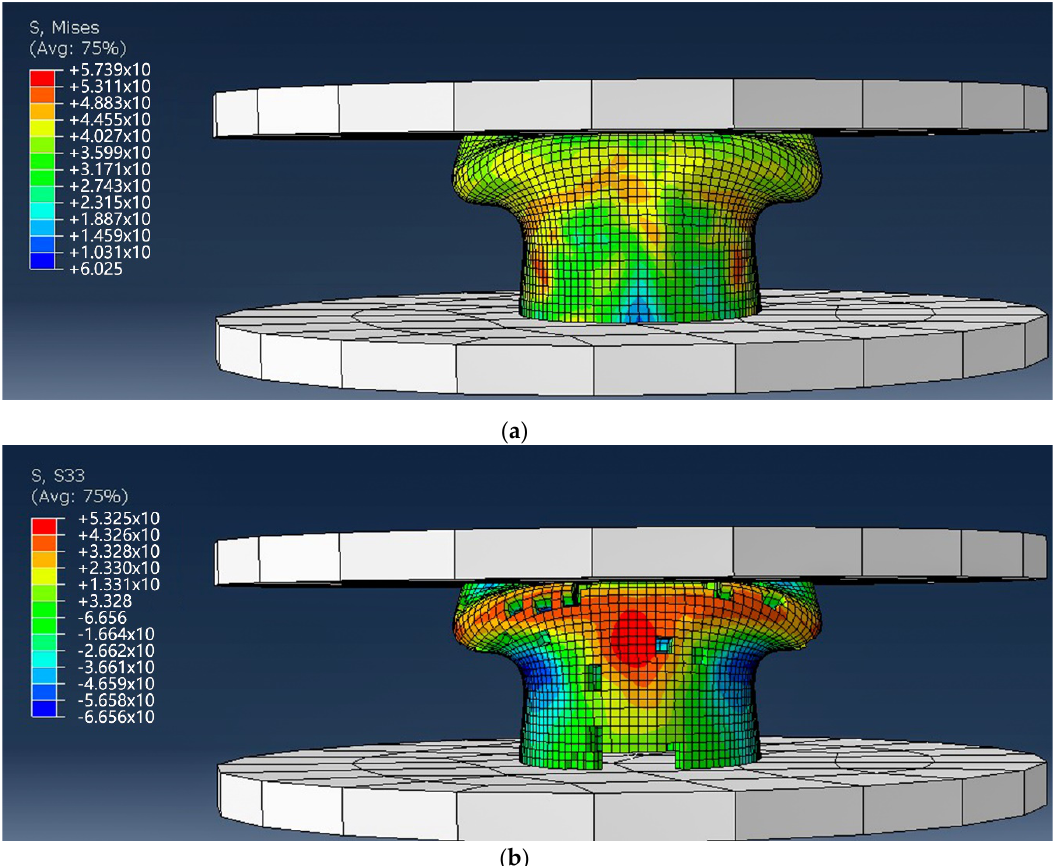
Figure 12. The final failure photograph of the 3D tubular woven composites. ( a ) The final failure photograph of the 3D tubular woven composites under Mises; ( b ) The final failure photograph of the 3D tubular woven composites under S33 direction.